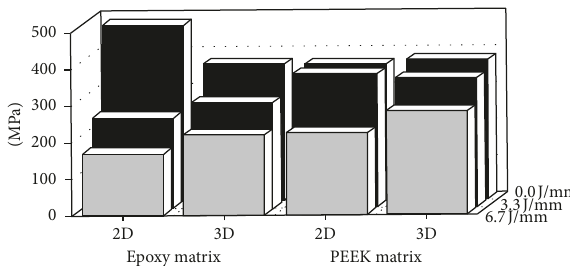
Figure 7: Influence of textile pattern and resin type on the compression stress before and after impact